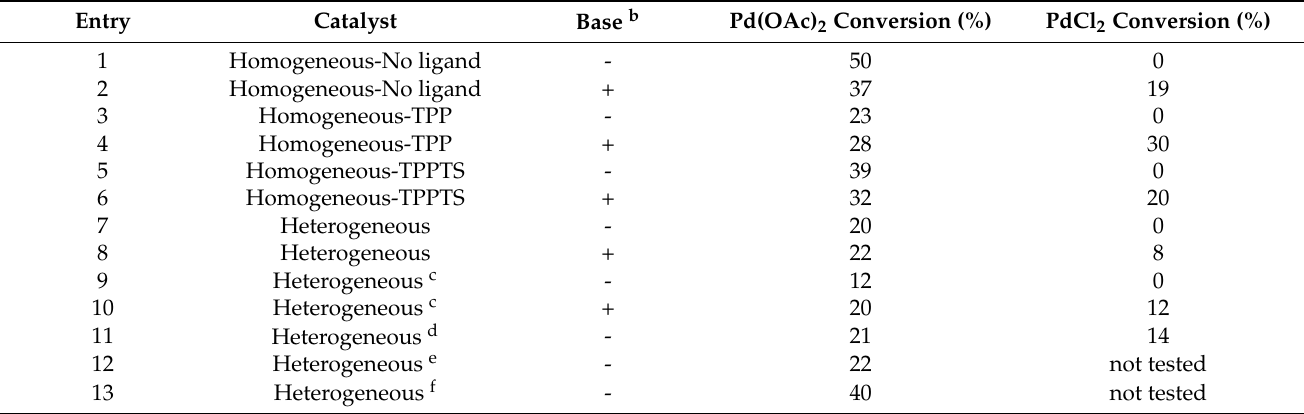
Table 1. Homogeneous and heterogeneous reactions in ethanol a